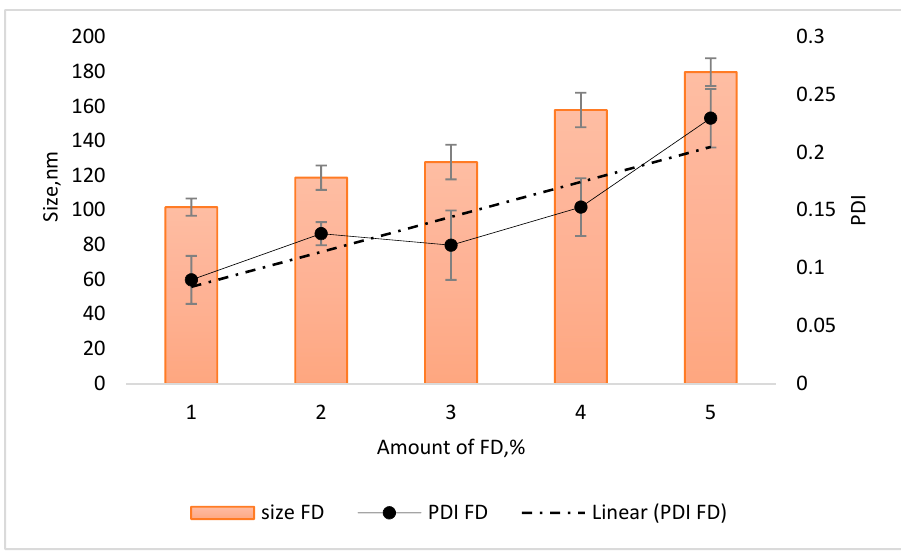
Figure 2. E ff ect of the composition of active (FD) on size and PDI of FDNLC. Experiments were done in triplicate ( n =